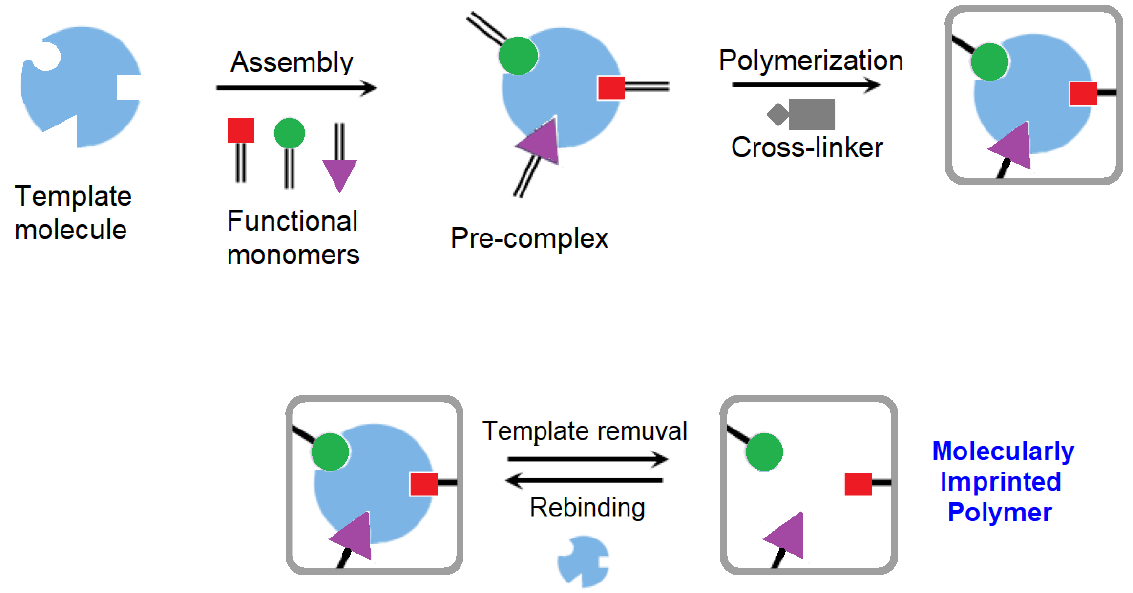
Figure 19. Scheme of a MIP preparation. (Adapted with permission from [53], open access Creative Common CC licenced 4.0, MDPI)